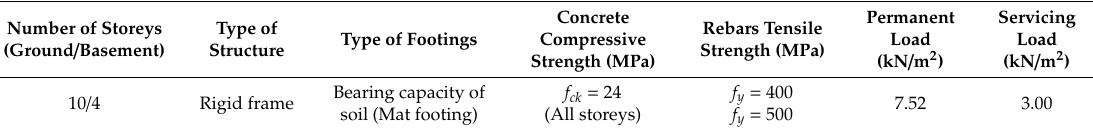
Table 3. Profile of the studied building.